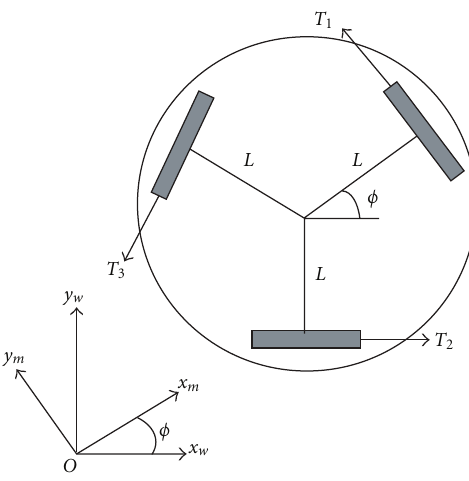
Figure 2: Omnidirectional robot